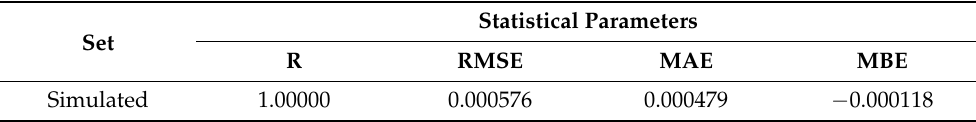
Figure 8. Comparison between predicted and experimental data using the simulation data. Table 13. Statistical parameters of the (2-10-10-1) model during the simulation